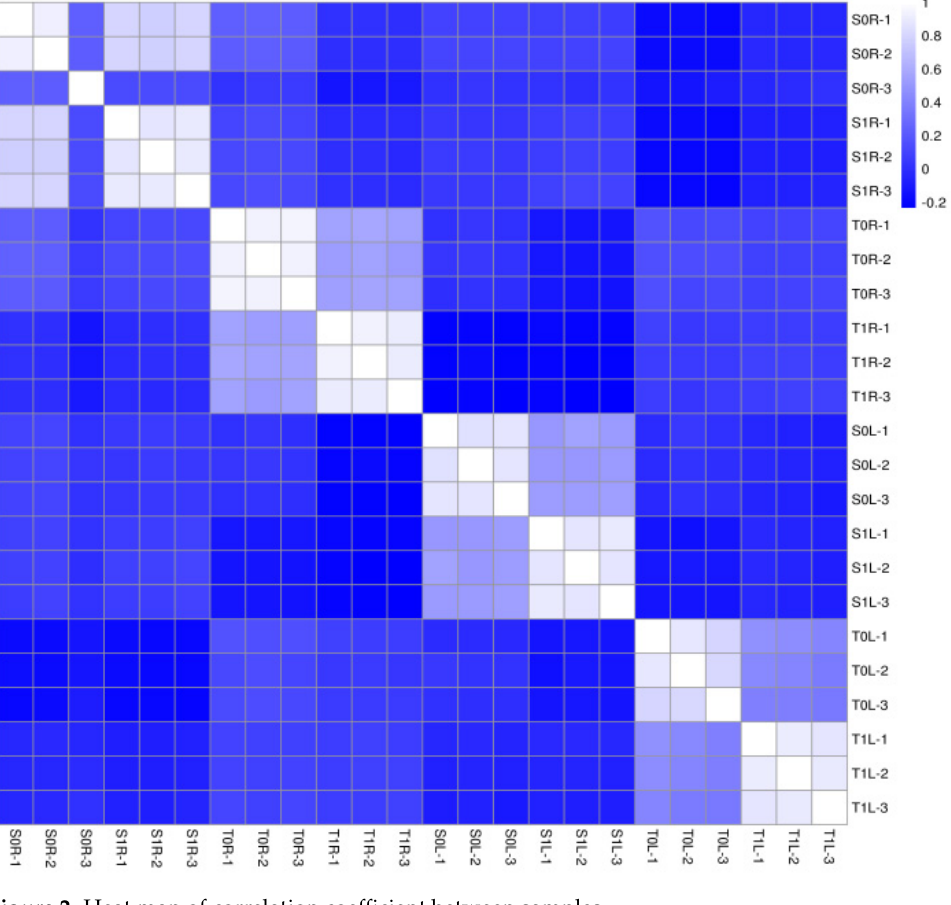
Figure 2. Heat map of correlation coefficient between